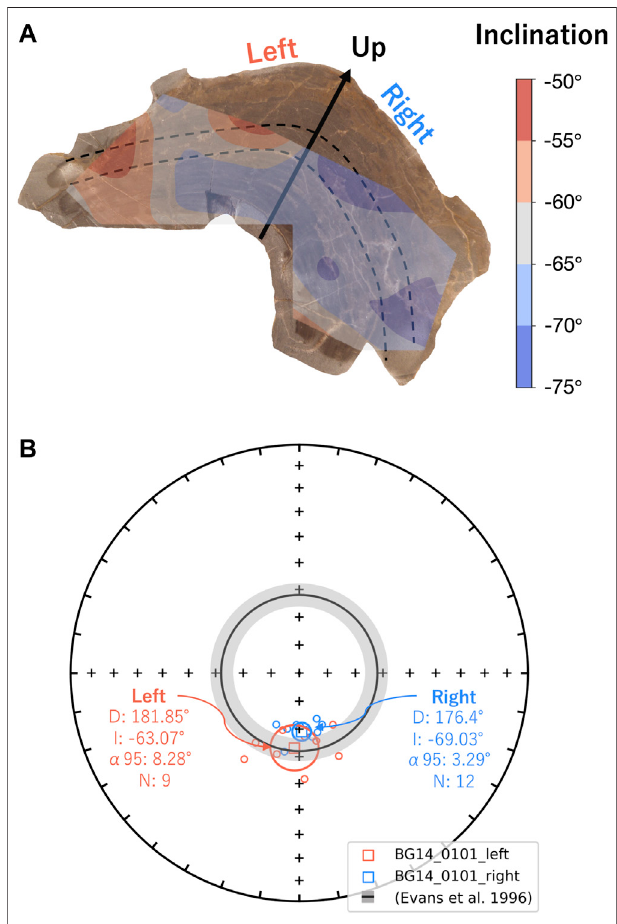
FIGURE8|(A) Inclination mappingofthe BG14_0101 sampleslice with contouringbycubicinterpolation.Theblackarrowanddashed linesrepresent up directions and laminations. (B) Equal area stereographic projection of reoriented magnetization components of the sample BG14_0101 by rotating total mean declination to the magnetic north. Specimen declinations andinclinationsfromtheleftandrightsideswithrespecttothestratigraphicup direction (black arrow) are symbolized as red and blue circles, respectively. The mean direction of each group is marked as a square symbol with α 95 ellipses. The gray shading annulus on the BG panel (inclination: − 62 ± 4 ° ) represents the expected directions derived from sedimentary beds in the same formation (Evans et al.,